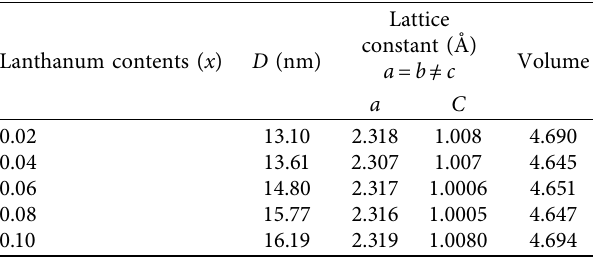
Figure 3: Lanthanum concentration and crystalline size of man- Figure 2: XRD pattern of (Ba � 0.02 to 0.10 1 − x La x Mn y Fe 12 − y O19) x ganese barium hexaferrite. and y � 0.2 to 0.10 for Table 1: Lanthanum concentration, crystalline size, lattice con- stant, and volume of hexaferrites have been calculated.